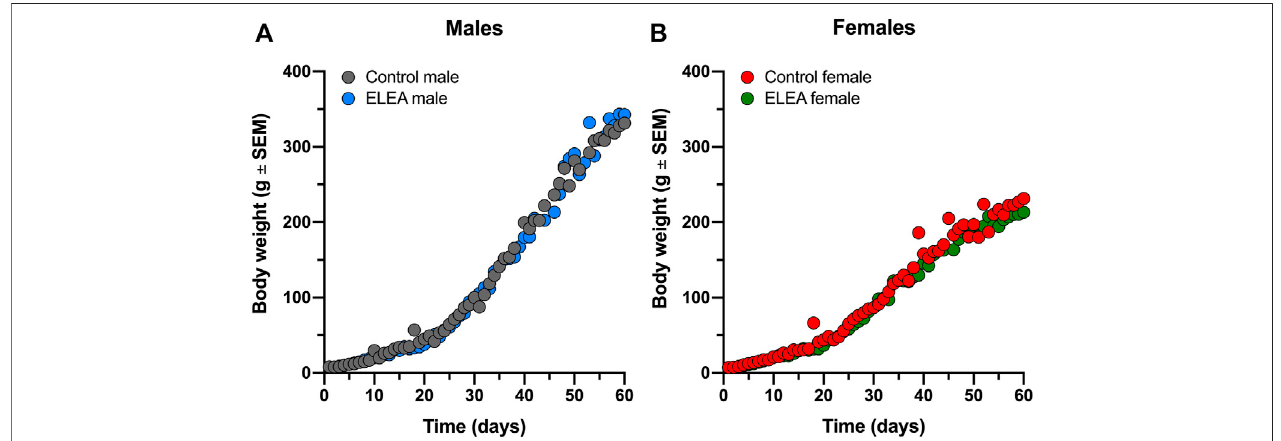
FIGURE1| ELEAdidnotaffectbodyweightofmaleandfemalerats.Therearenodifferencesinweightgainwithin (A) maleand (B) femaleratsperinatallyexposed toantibiotics (grey) and theirrespectivecontrols (black). Animalswereweighed frombirth untilPD63 (control males, n =31; ELEAmales, n =22;controlfemales, n =27; ELEA females, n =